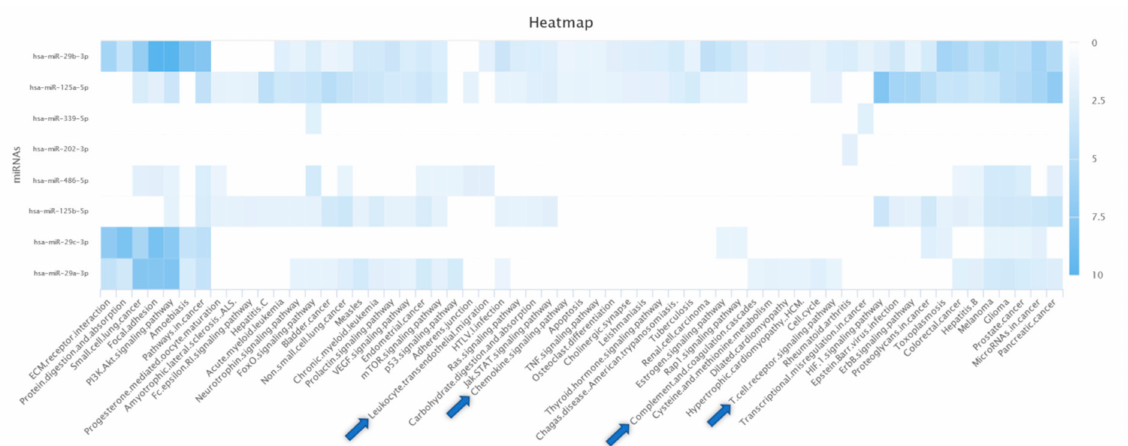
Figure 2. Enriched KEGG pathways of predicted miRs obtained from the miRDB database. Enriched pathways with at least two associated miRs were shown. The color of individual fields represents the − log10-transformed p -value of the respective enrichment results. Darker colors indicate more significant associations between an miR and the target pathway. Enriched KEGG pathways in the category of immune system are indicated by blue arrows.